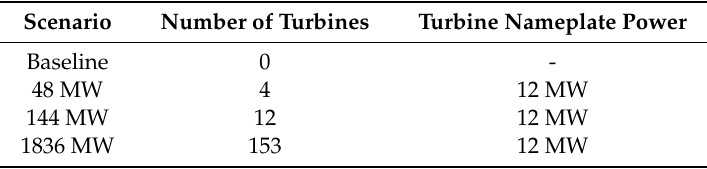
Table 2. Study scenarios for o ff shore wind.